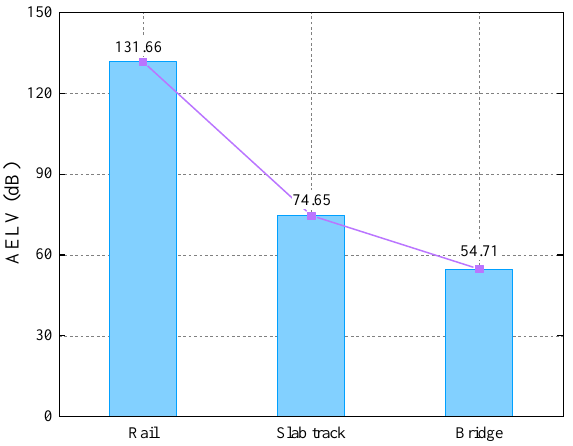
Figure 6. The average energy levels of vibration (AELVs) of the track – bridge system. Figure 8. The average energy levels of vibration (AELVs) of the track–bridge